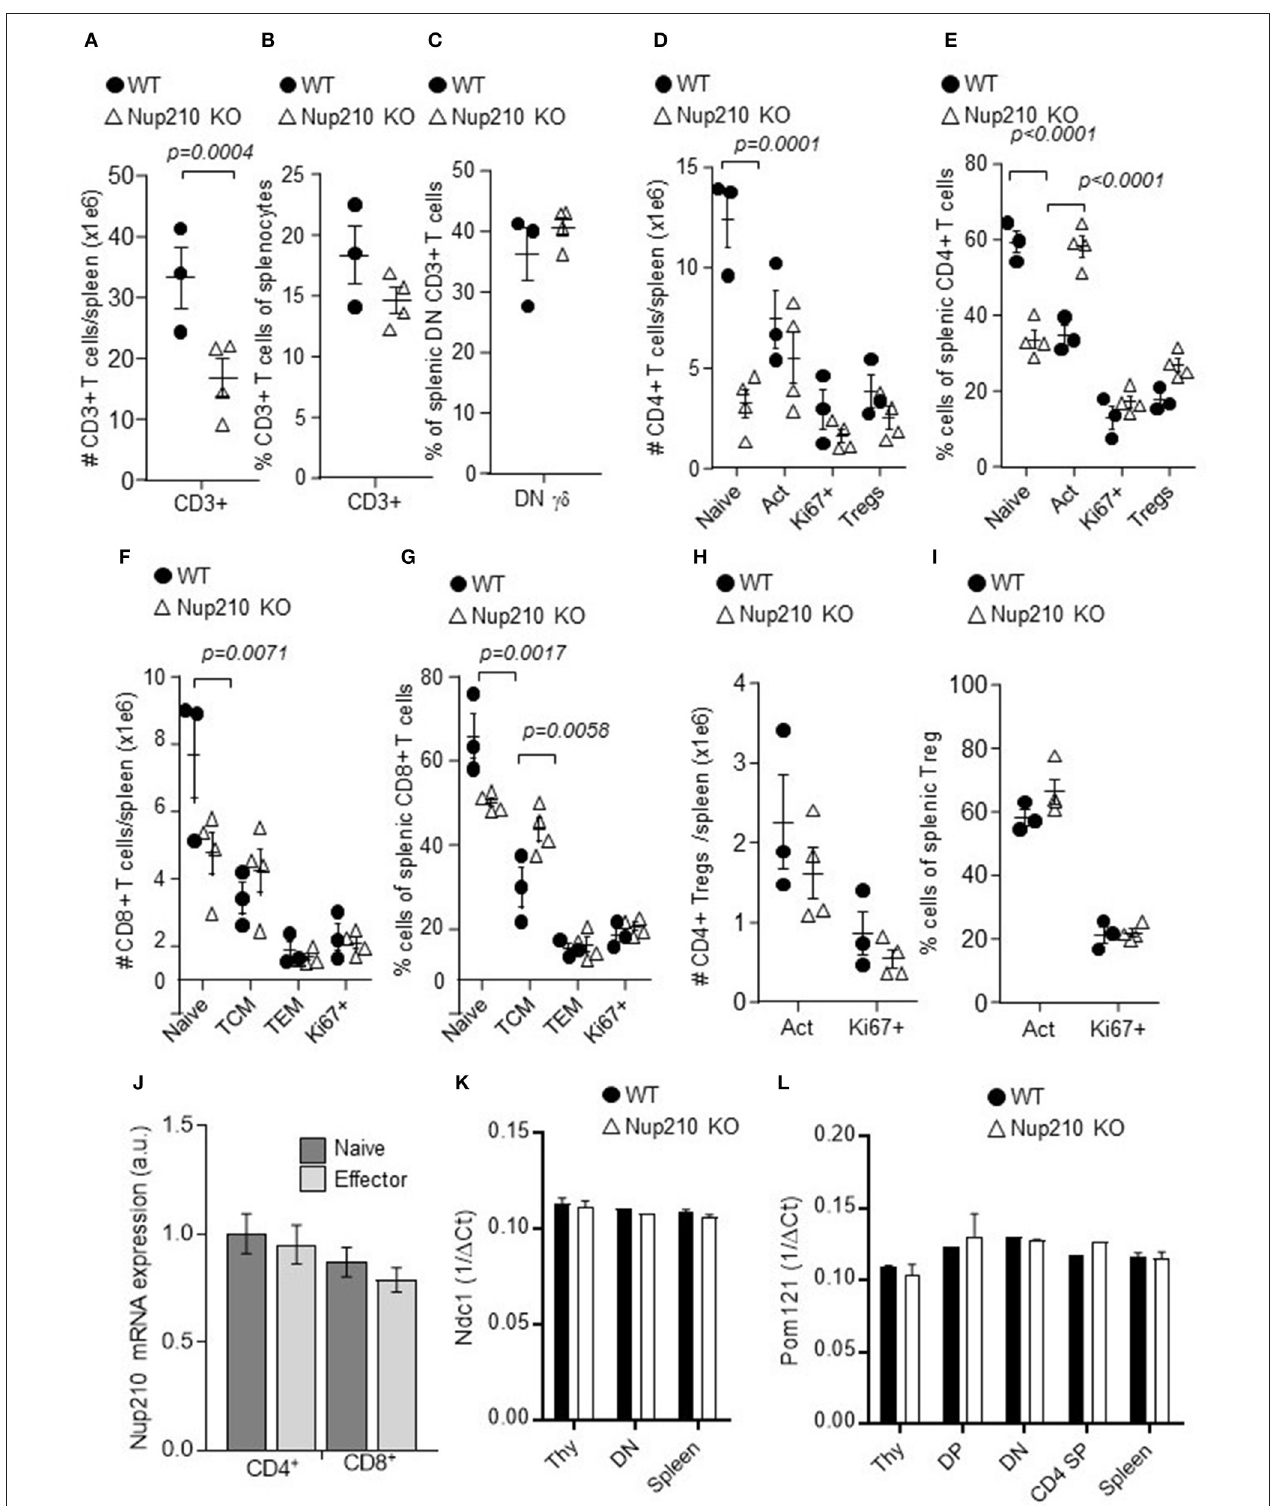
FIGURE 3 | Altered peripheral T cell biology in Nup210 knockout mice are viable and have intact thymic biology. Wildtype and Nup210 KO mice ( n = 3, 4) were assessed by flow cytometry for absolute and relative numbers of CD4 and CD8T cell subset in the spleen. (A) Absolute number and (B) percentage of CD3 + T